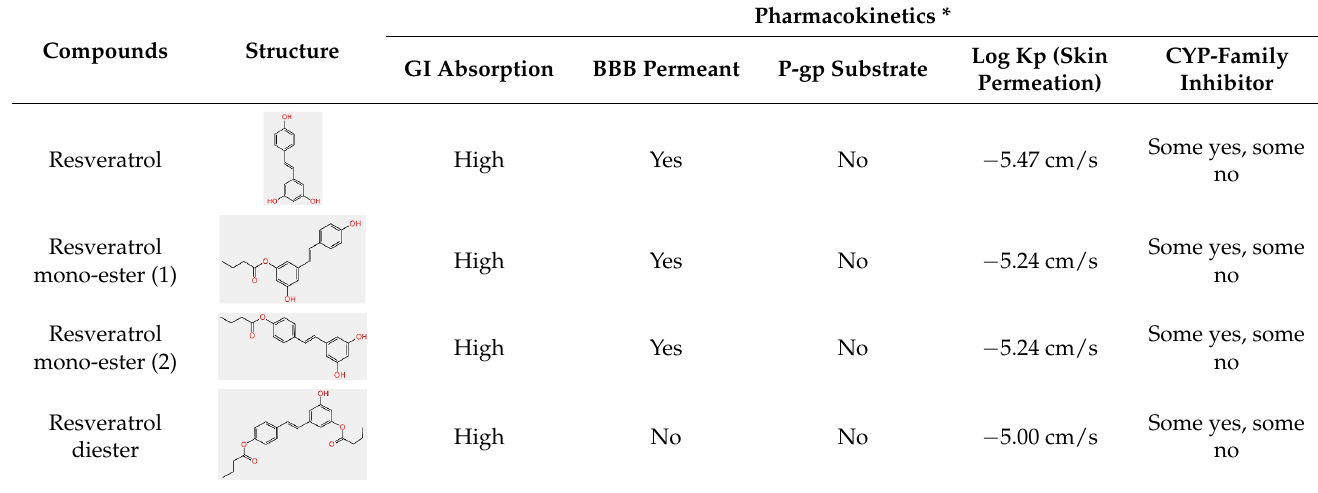
Figure A1. The graphical abstract of this manuscript. Table A1. The SwissADME evaluation of resveratrol, resveratrol mono-ester (1), resveratrol mono-ester (2), and resveratrol diester. Compounds